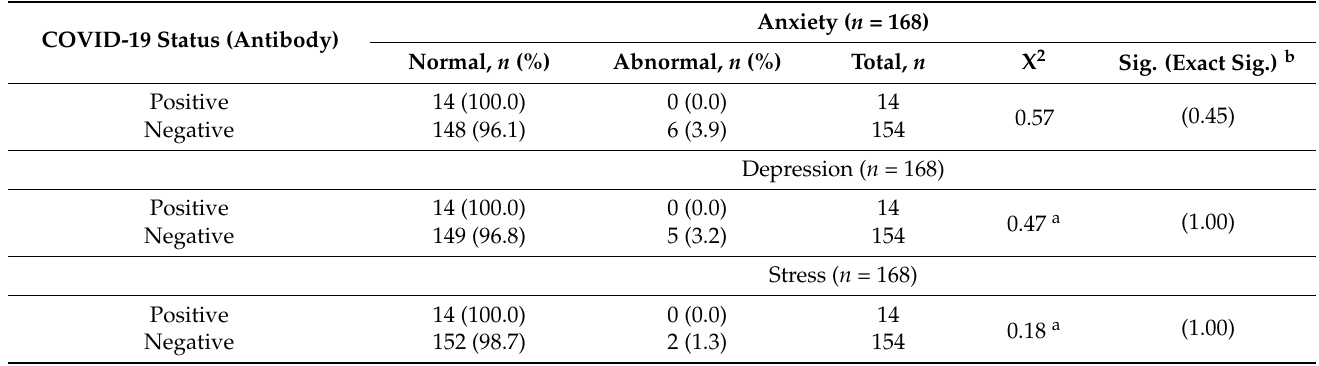
Table 4. Relationship between COVID-19 status and psychological distress variables.